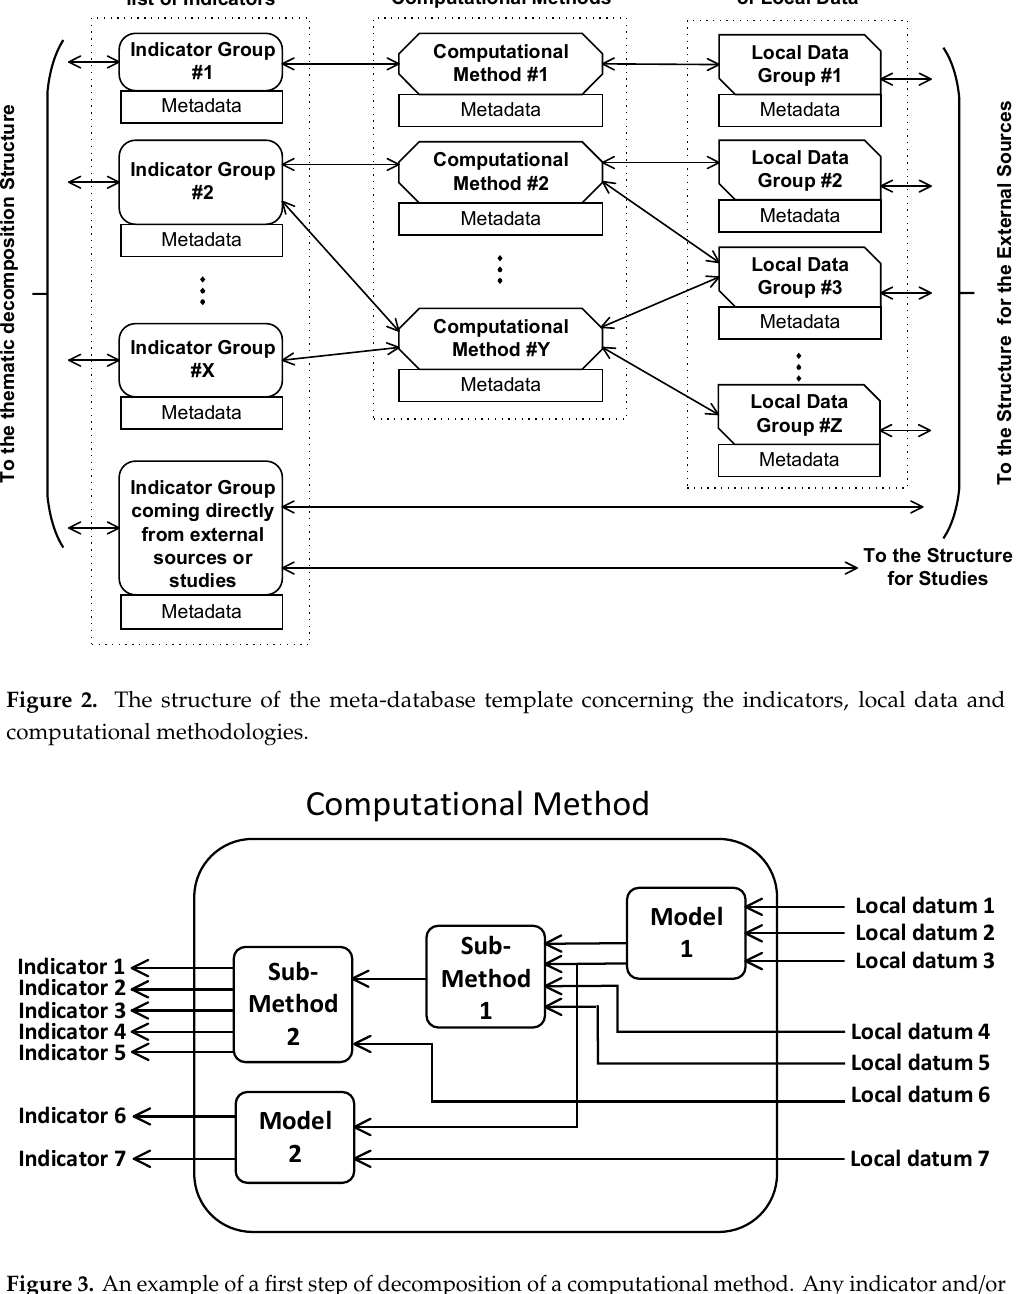
Figure 2. The structure of the meta-database template concerning the indicators, local data and computational methodologies.